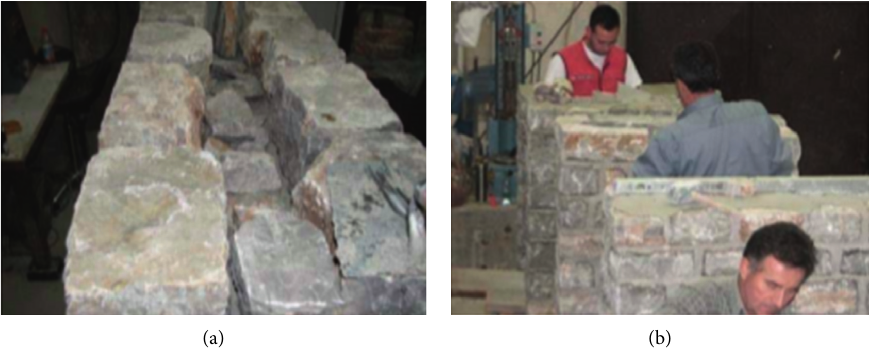
Figure 2: Construction of wall with no connecting stones [18].